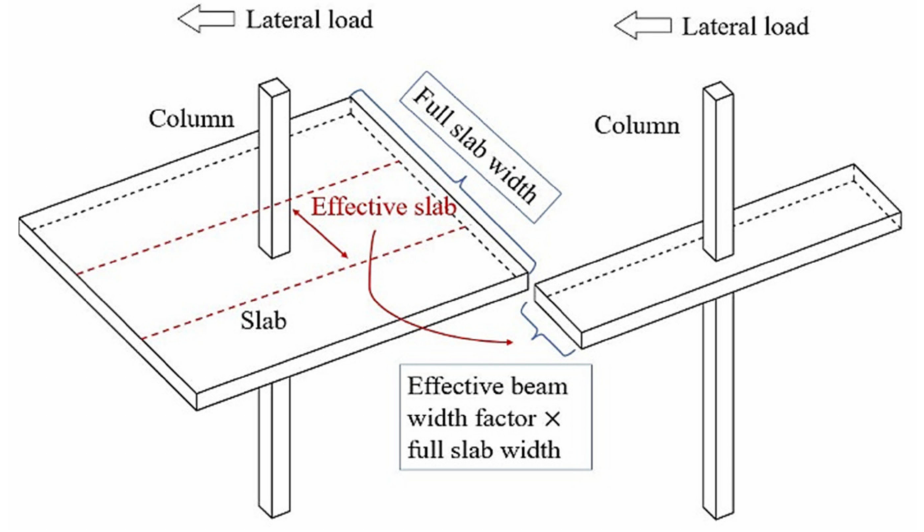
Figure 5. Definition of